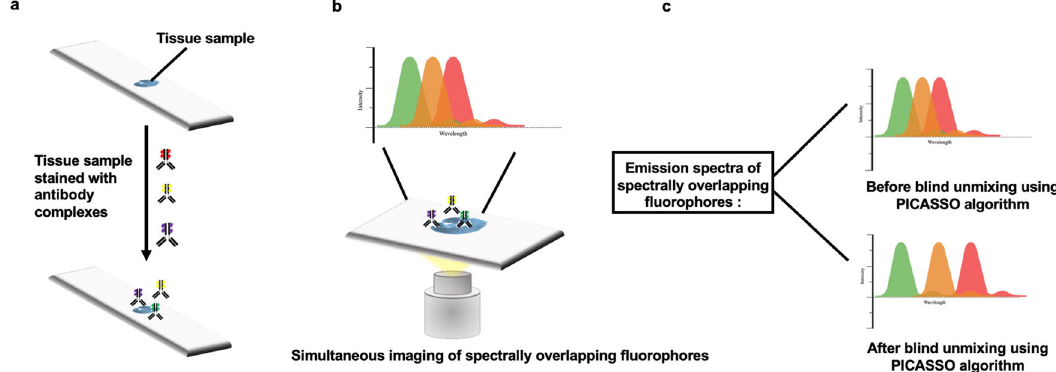
Fig. 1 Working Principle of PICASSO. a Simultaneous staining of protein targets using a cocktail of antibodies labeled with fl uorophores that have overlapping emission spectra. b Single-round imaging to detect targets. c Reference-free unmixing via mutual information minimization to construct ultra- high-plex multi-color fl uorescence